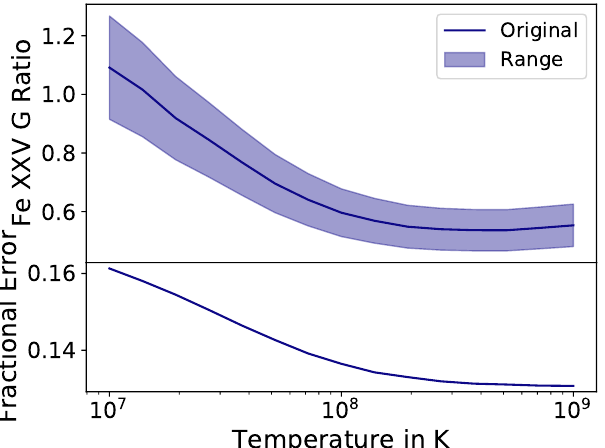
15% uncertainty on the direct excitation rates of the forbidden, ±